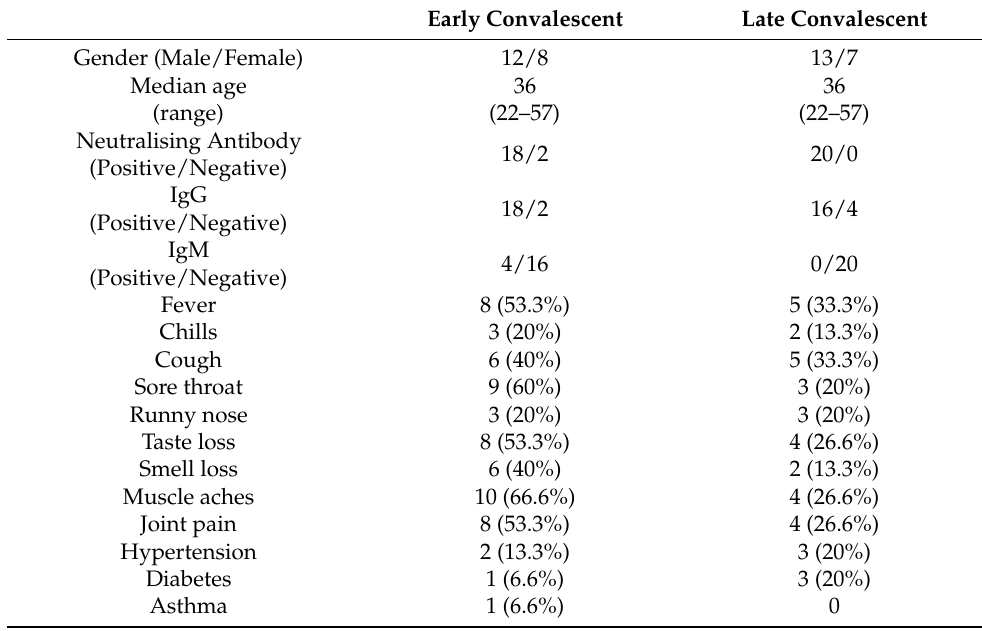
Table 1. Demographics and clinical symptoms of the study